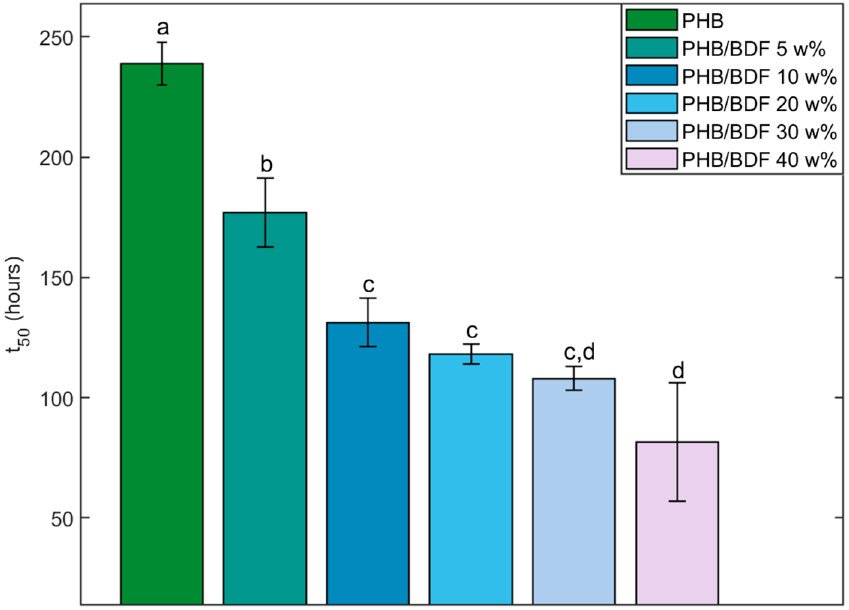
Figure 9. t 50 associated to each powder of PHB/BDF blend. Different letters mean a significant dif- ference as determined with a one-way ANOVA and Tukey post hoc range tests ( α = 0.05).